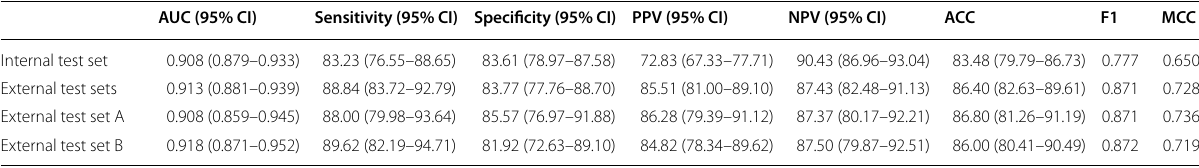
Table 2 Performance metrics for the DL model in the test sets